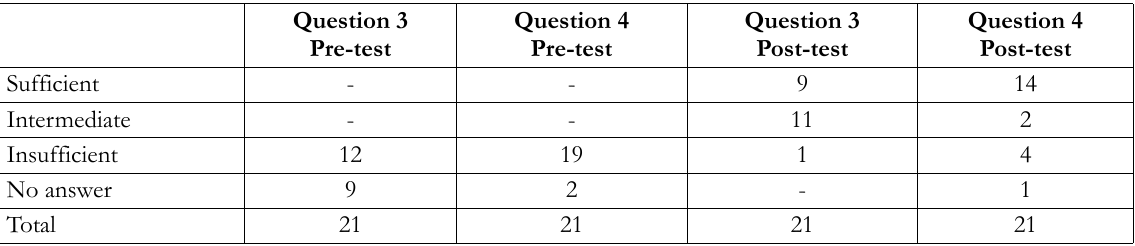
Table 4. The sufficiency of mental representations in responses to questions 3 &